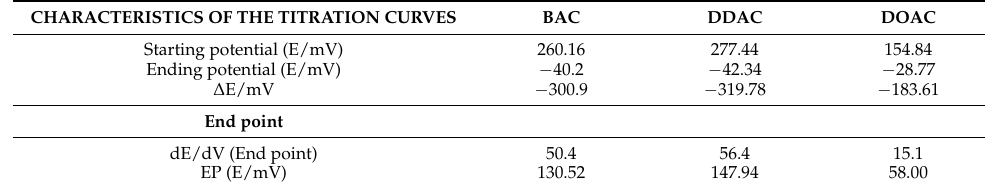
Table 2. Characteristics of the titration curves of the technical grade cationic surfactants: BAC, DDAD, and